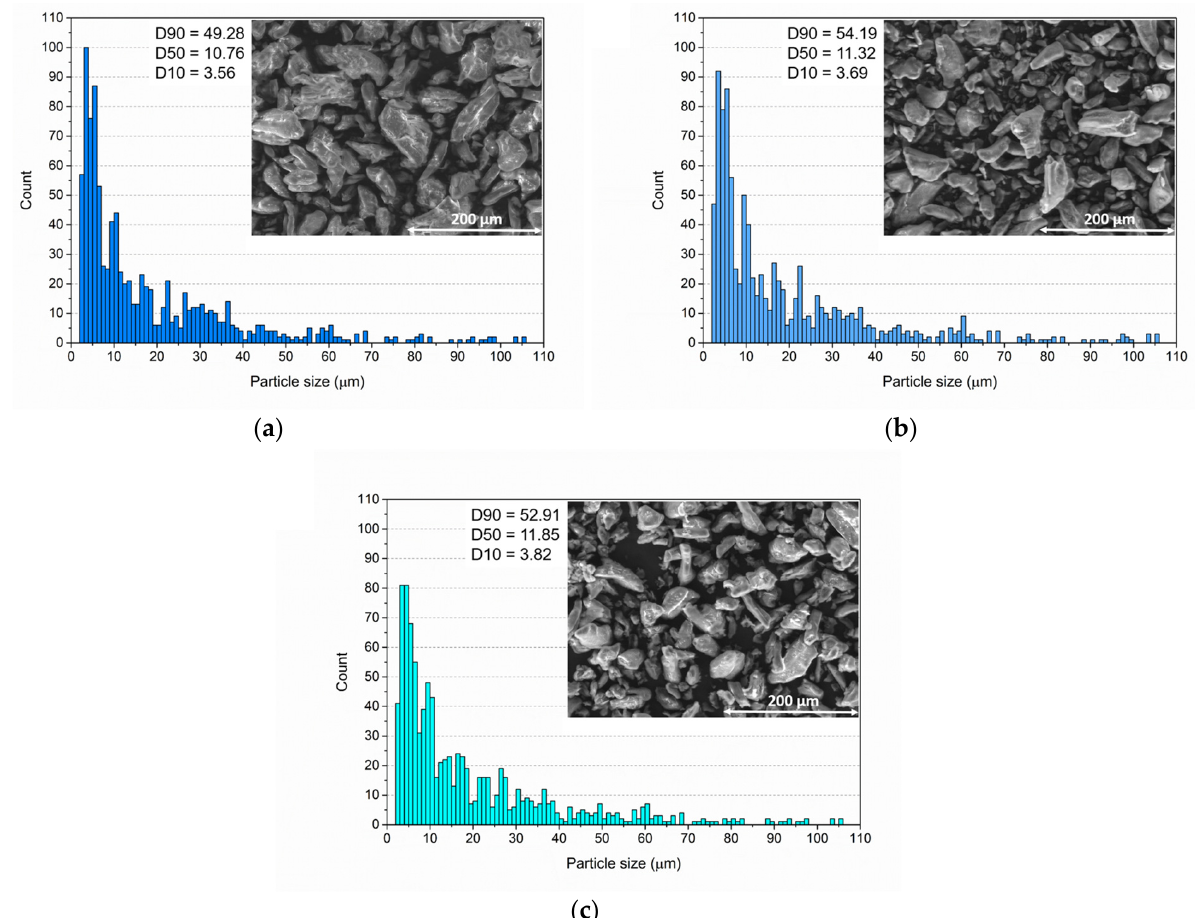
Figure 1. Size distribution analysis carried out with ImageJ on ( a ) olive pit powder, ( b ) olive pit powder functionalized with silane, and ( c ) olive pit powder functionalized with wax. The pictures of the powders were acquired by SEM (scale bar: 200 µm).